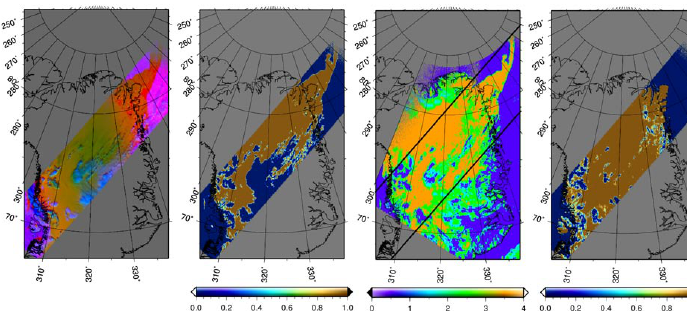
Figure 9. Greenland. AATSR: 4 May 2005, 15 h 07'47'', orbit number 21836, MODIS: 4 May 2005, 15 h 00'. Left panel is the false color composite (red is 11µm BT, green is 550nm reflectance, blue is 1.6µm reflectance) of initial AATSR scene; second left panel is the clear snow mask of AATSR scene (0 – not snow, 1 – clear snow) achieved with presented method; third left panel is MODIS cloud mask: 1 – cloudy, 2 – probably cloudy, 3 – probably clear, 4 – clear; right panel is operational AATSR cloud mask from level-1b product: 0 – cloudy, 1 – clear.